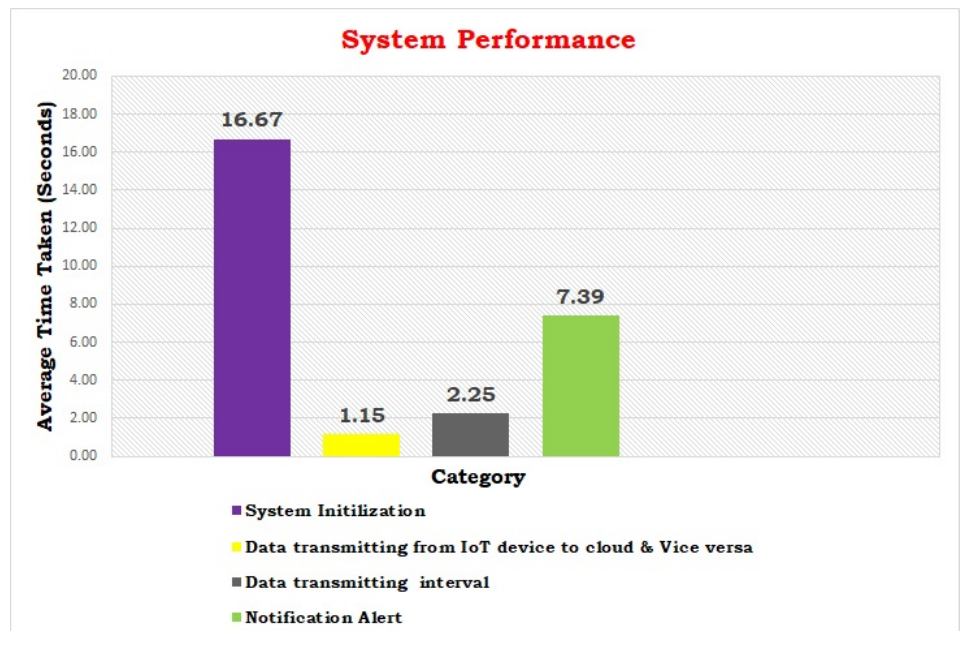
Figure 25. System performance.